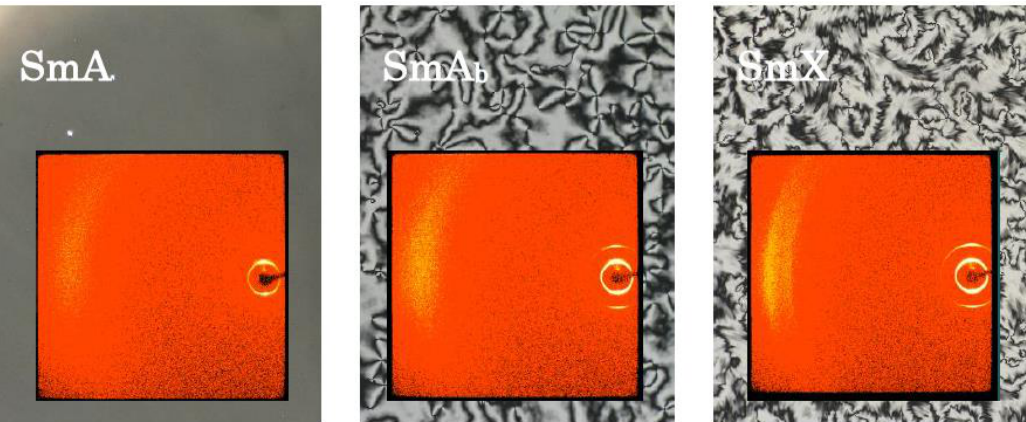
Figure 5. POM images and corresponding X-ray diffraction patterns obtained for CB6OBA:10OS in the SmA, SmA b and SmX phases (left to right).